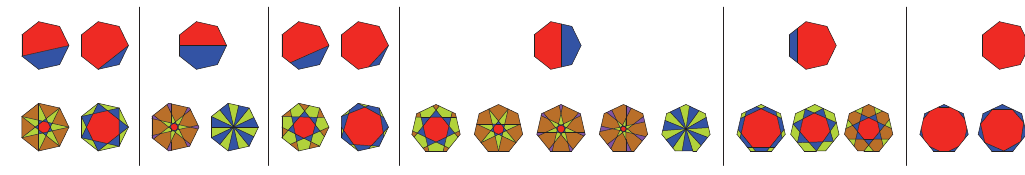
Figure 11. Cutting a heptagon with 1 or 7